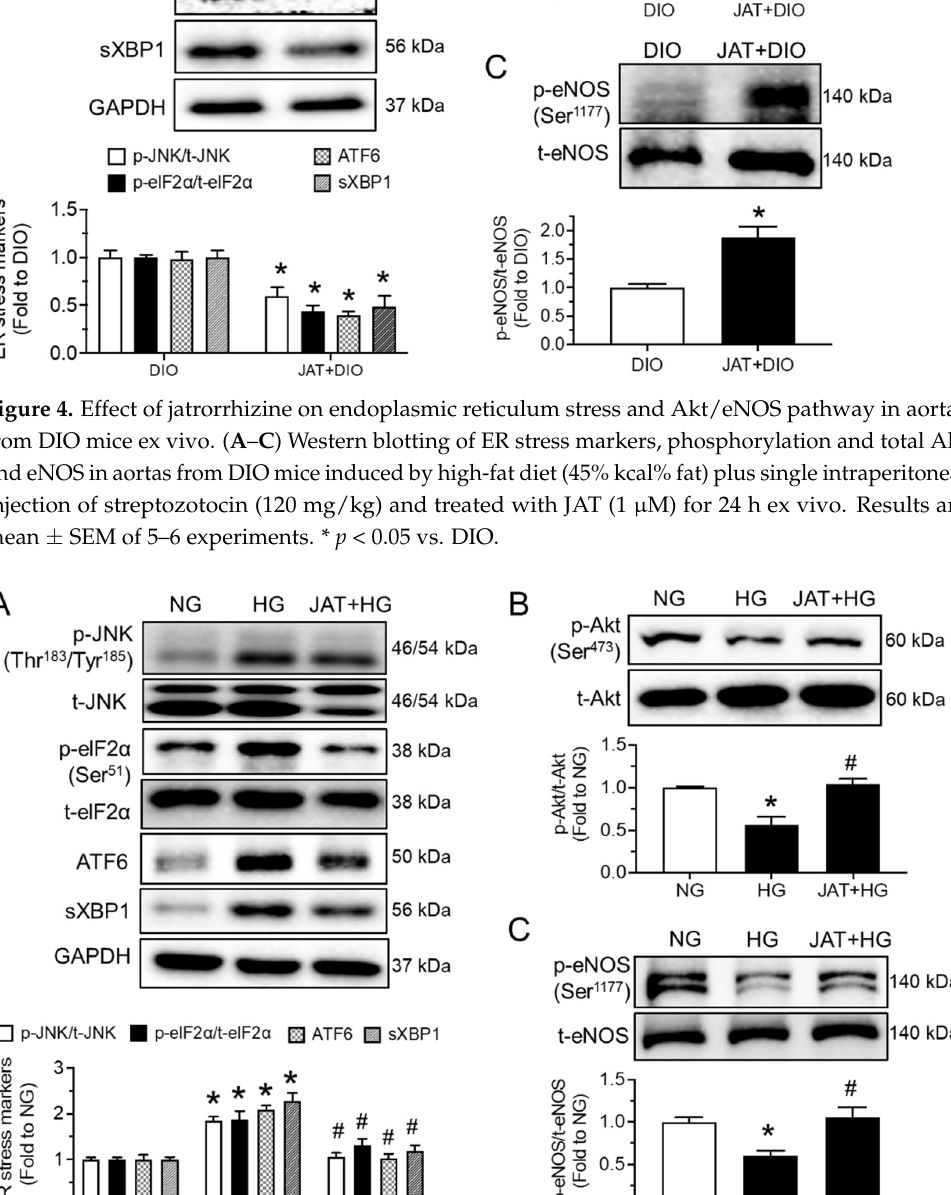
Figure 5. Effect of jatrorrhizine on endoplasmic reticulum stress and Akt/eNOS pathway in human umbilical cord vein endothelial cells (HUVECs). ( A – C ) Western blotting of ER stress markers and Akt/eNOS in HUVECs treated with HG (30 mM) and JAT (1 μ M) for 48 h. Results are mean ± SEM of 5–6 experiments. * p < 0.05 vs. NG; # p < 0.05 vs. HG.